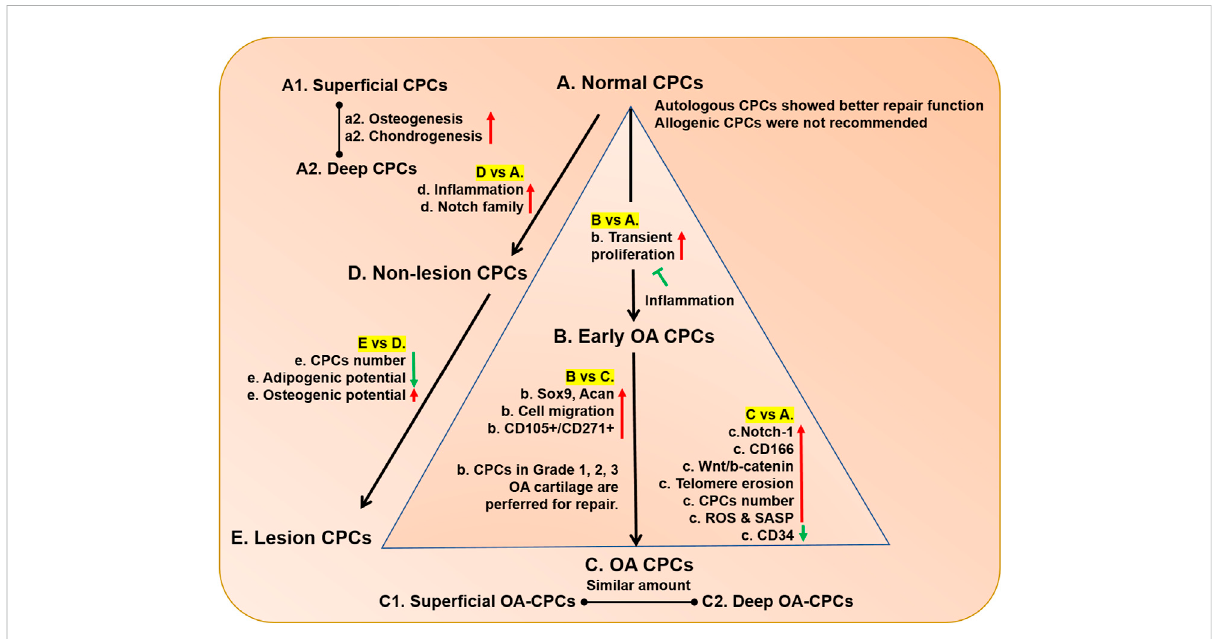
FIGURE 4 The comparison of CPCs in normal and OA cartilage. The CPCs in normal, early OA, and late OA cartilage were compared, while the CPCs in normal, non-lesion, and lesion OA cartilage were compared. The capitalized (A – E) means CPCs from healthy cartilage, early OA CPCs, OA CPCs, CPCs from non-lesion OA cartilage, CPCs from lesion OA cartilage, respectively. a, b, c, d, e, f, g in lowercase means the cell properties in A, B, C, D, E cells compared with cells being connected by line, respectively. The red arrow means upregulation; the green arrow means downregulation. The blue symbol means inhibition.